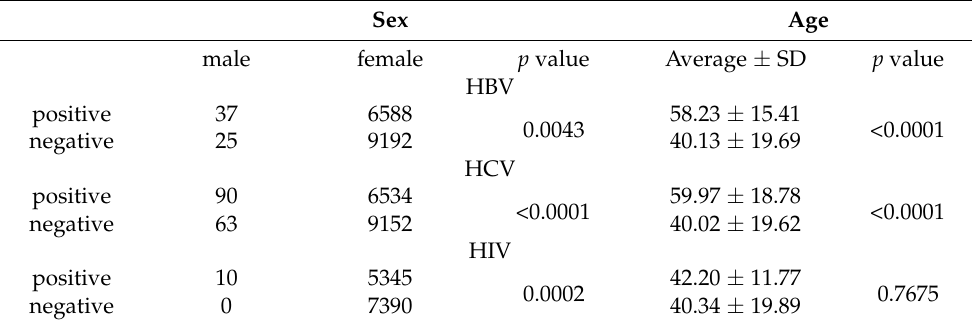
Table 5. Relationship between sex, age, and infectious diseases.